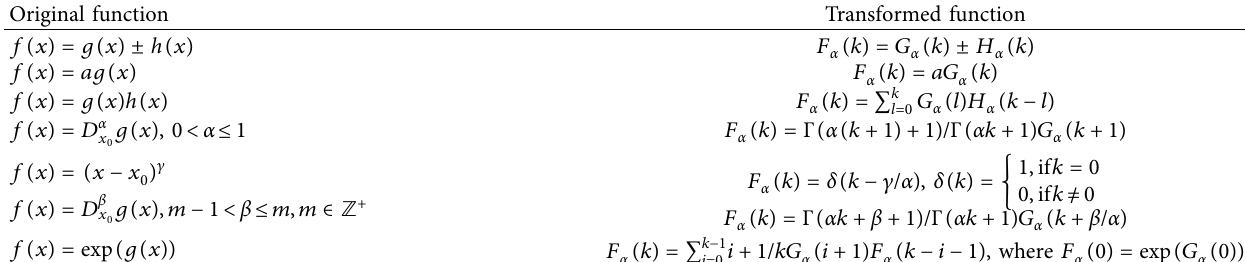
Table 1: Basic properties of GDTM